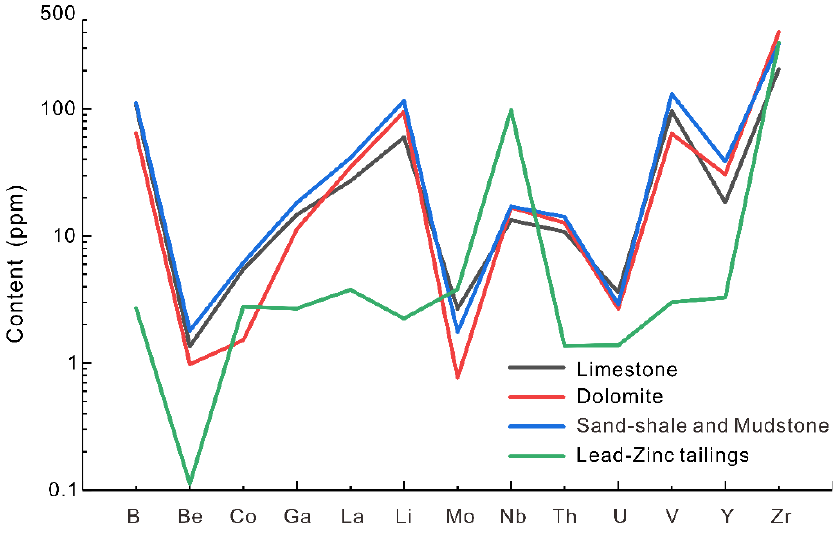
Figure 3. Mean tracer concentrations of different sources.